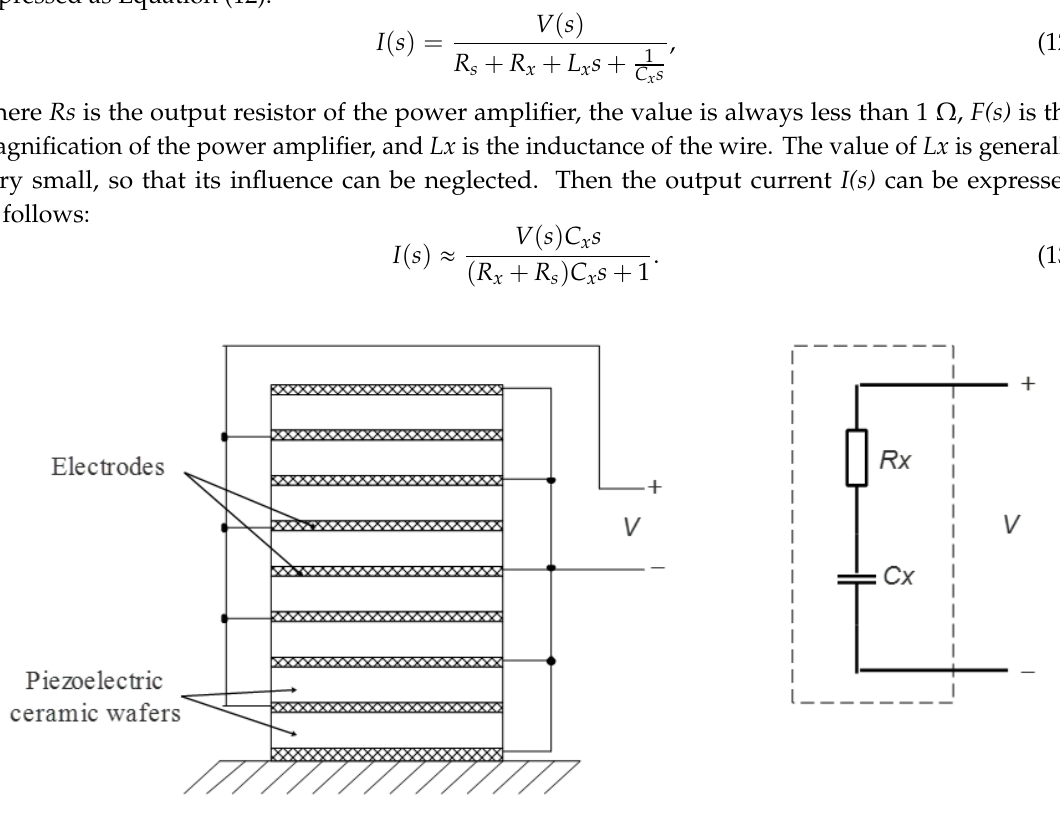
Figure 8. The model of piezoelectric stack